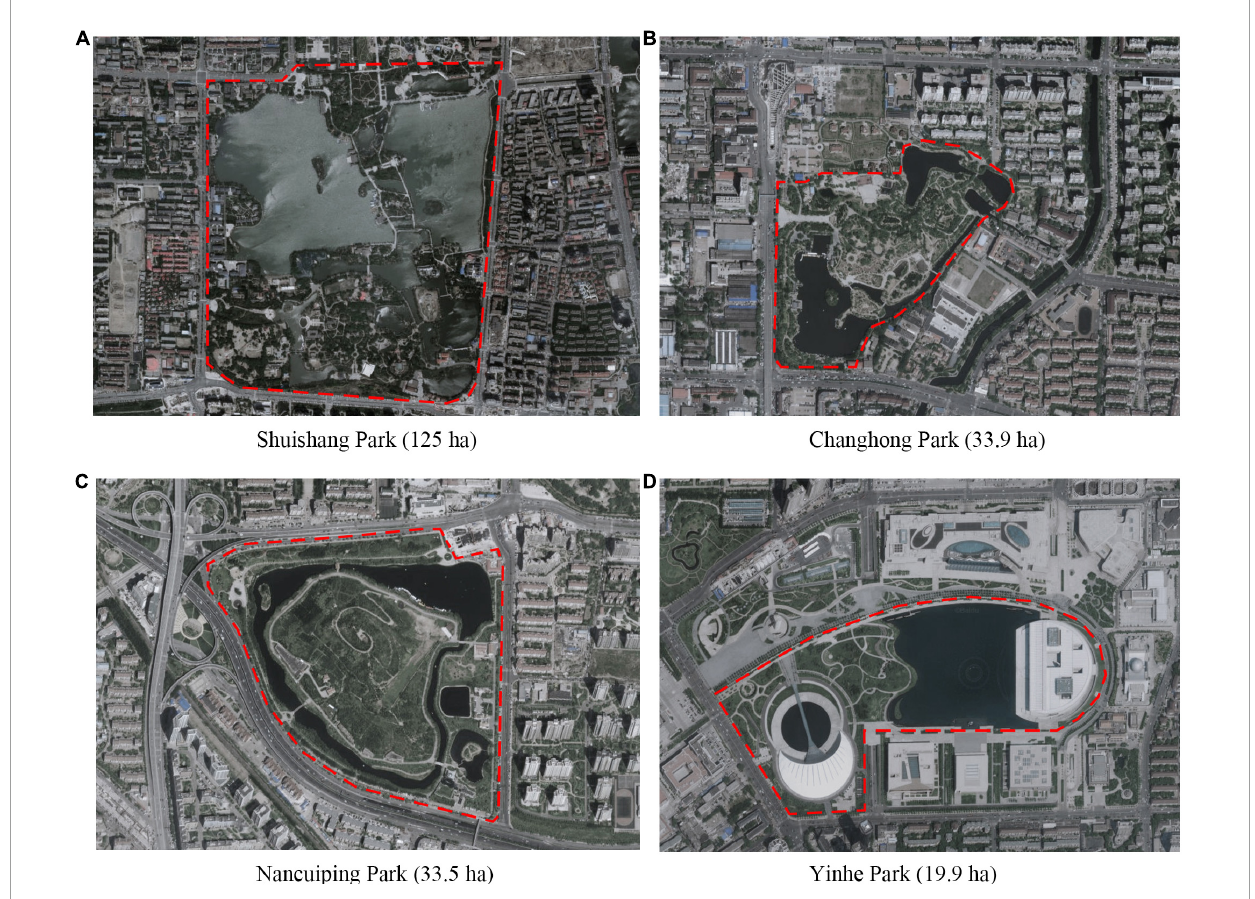
FIGURE1 Satellite views of four survey urban parks. (A) Shuishang Park; (B) Changhong Park; (C) Nancuiping Park; (D) Yinhe Park.